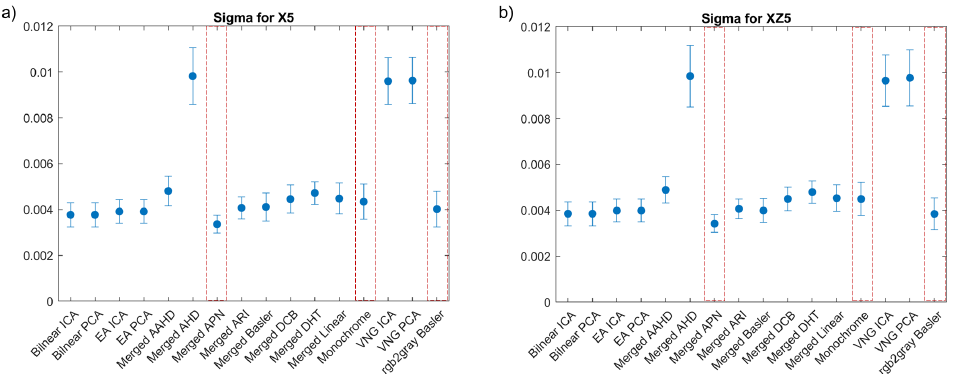
Figure 3. Mean correlation coefficient (sigma) and standard deviation values as calculated for ( a ) X5 shift and ( b ) XZ5 shift. Red boxes indicate the selected